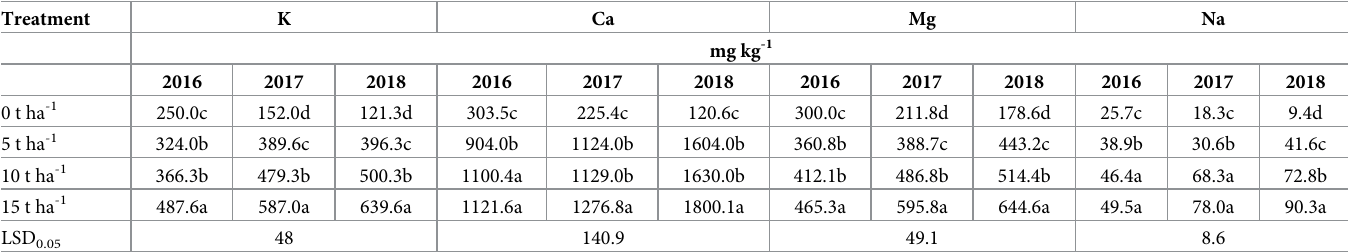
Table 11. Soil exchangeable cations (K, Ca, Mg and Na) as influenced by compost application rates over a three year study (2016 to 2018) at the Politsi orchard. Treatment K